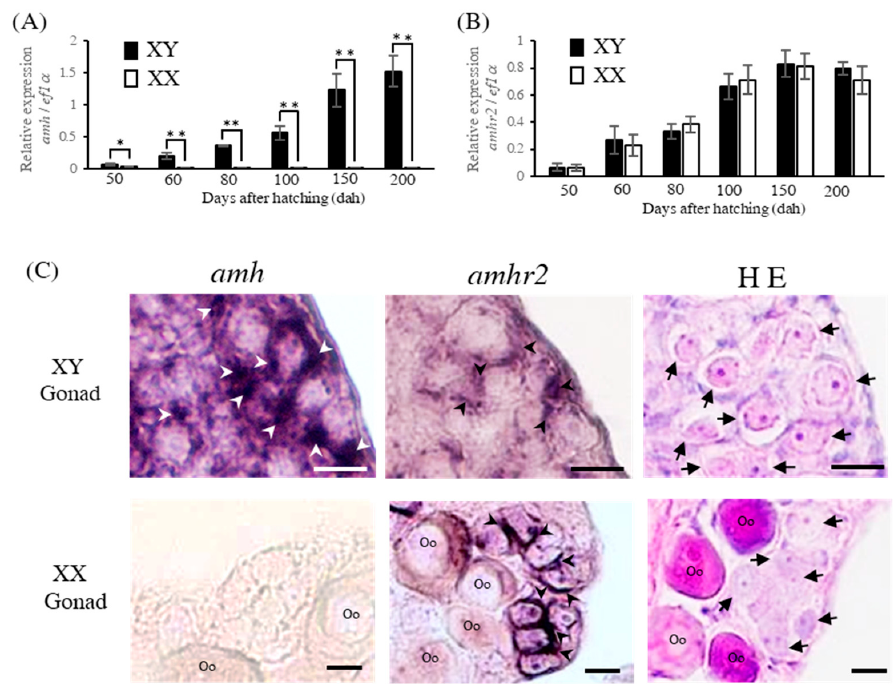
Figure 1. Expression analysis of amh and amhr2 in XY and XX flounder. Real-time PCR analysis of amh ( A ) and amhr2 ( B ) expression in XY and XX flounder from the sexually indifferent stage (50 dah) to the stage of clear differentiation in testis or ovary (200 dah). * p < 0.05, ** p < 0.01. ( C ) Cellular localizations of amh and amhr2 in the flounder gonads (200 dah) by in situ hybridization. Arrowheads indicate signals positive for amh or amhr2 transcripts, while arrows indicate gonium cells. Oo: oocyte. Scale bar: 20 µ